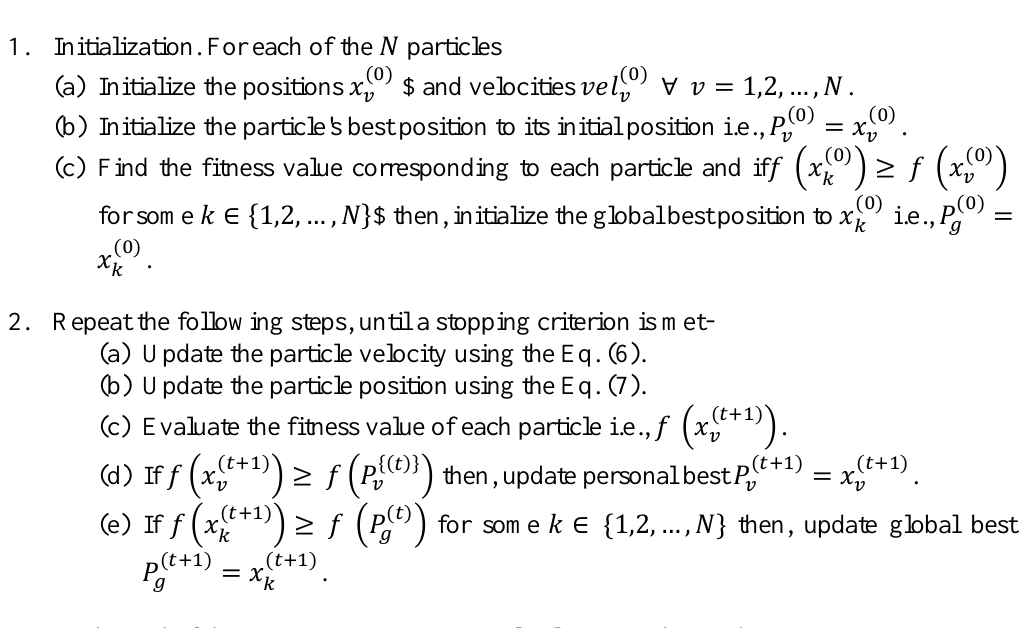
Algorithm 1: Pseudo Code of the